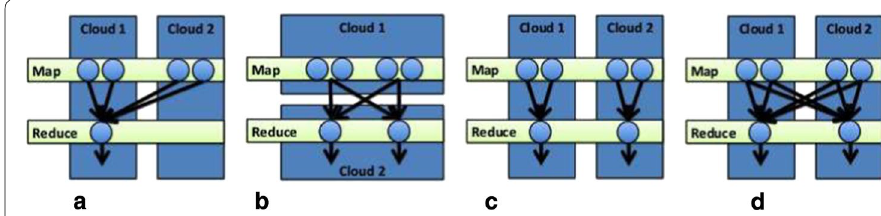
Fig. 2 The four Execution categories for HybrEx MapReduce [62]. a Map hybrid. b Horizontal partitioning. c Vertical partitioning. d